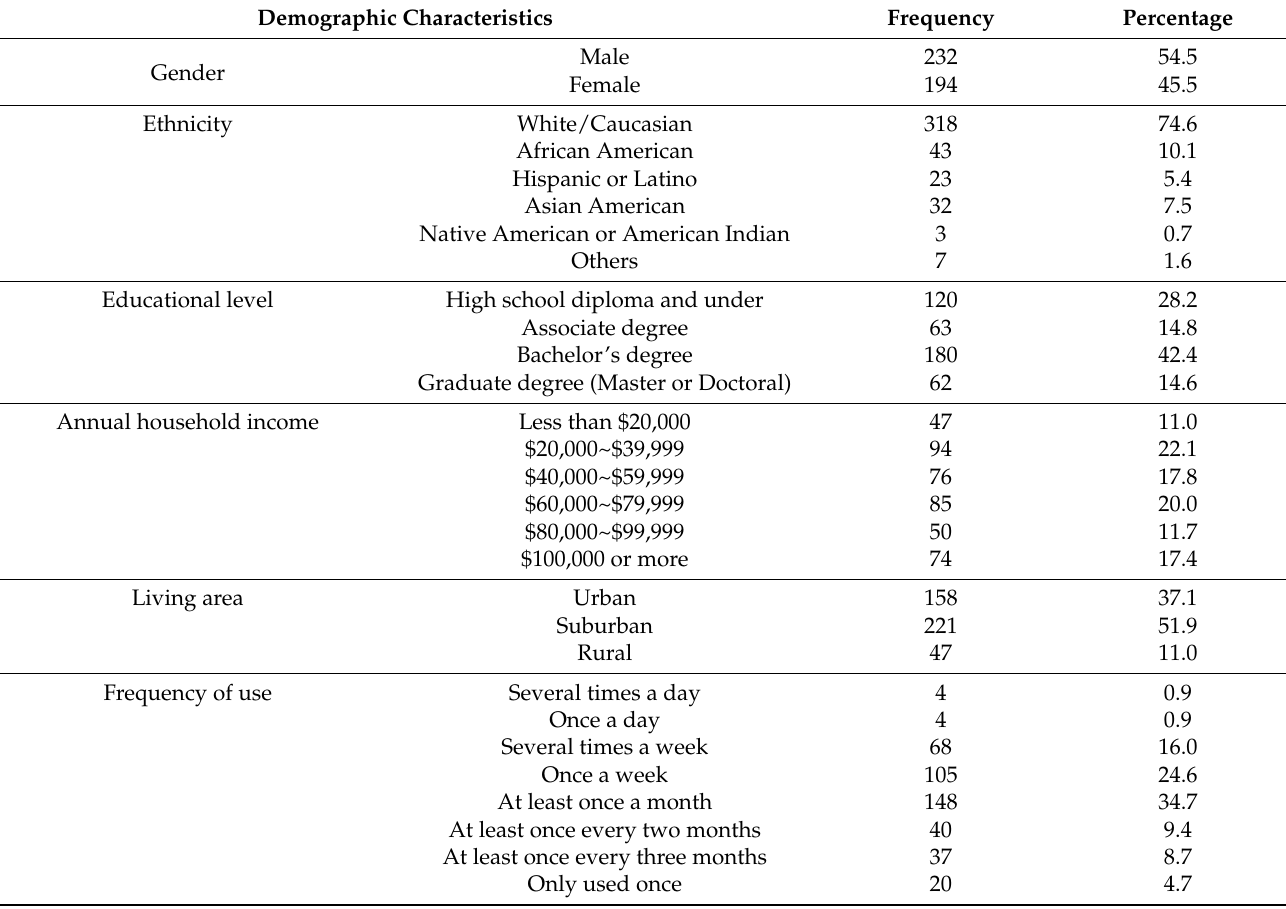
Table 1. Profile of the respondents.